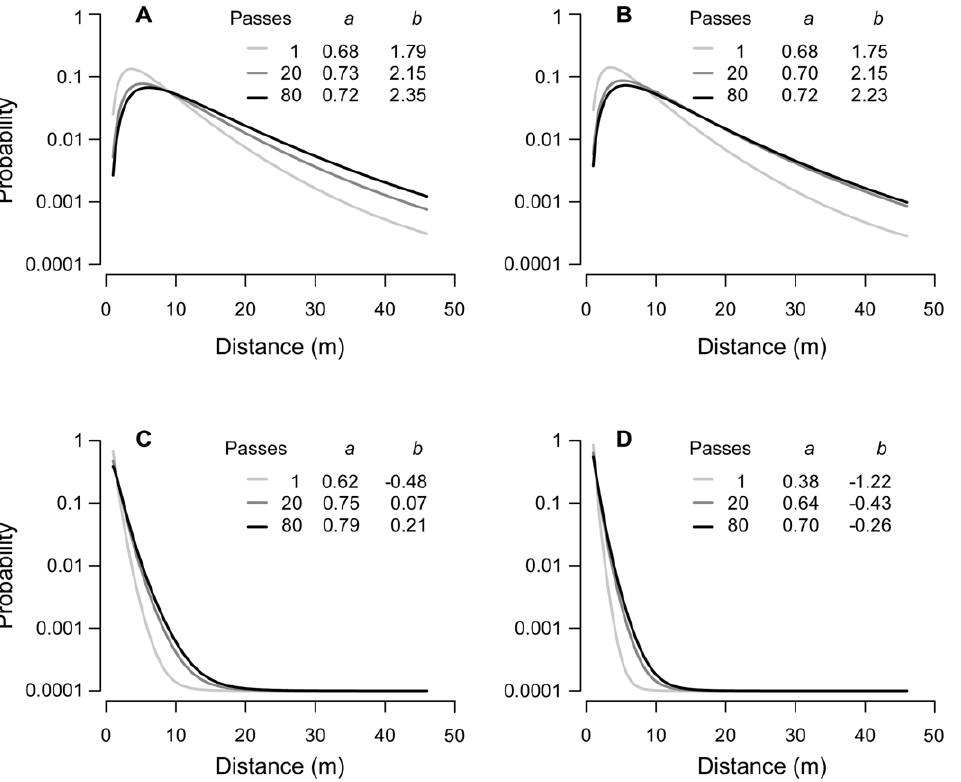
Figure 3. Effect of the number of vehicle passes on the shape of the fitted dispersal kernel (Lognormal function). (A) Ailanthus altissima , (B) Clematis vitalba , (C) Ambrosia artemisiifolia , and (D) Brassica napus . The y-axis is on a log scale and 0.0001 was added to all probabilities to show zero values. Inset tables show parameter estimates ( a =scale parameter, b =shape parameter) for the different numbers of vehicle passes.